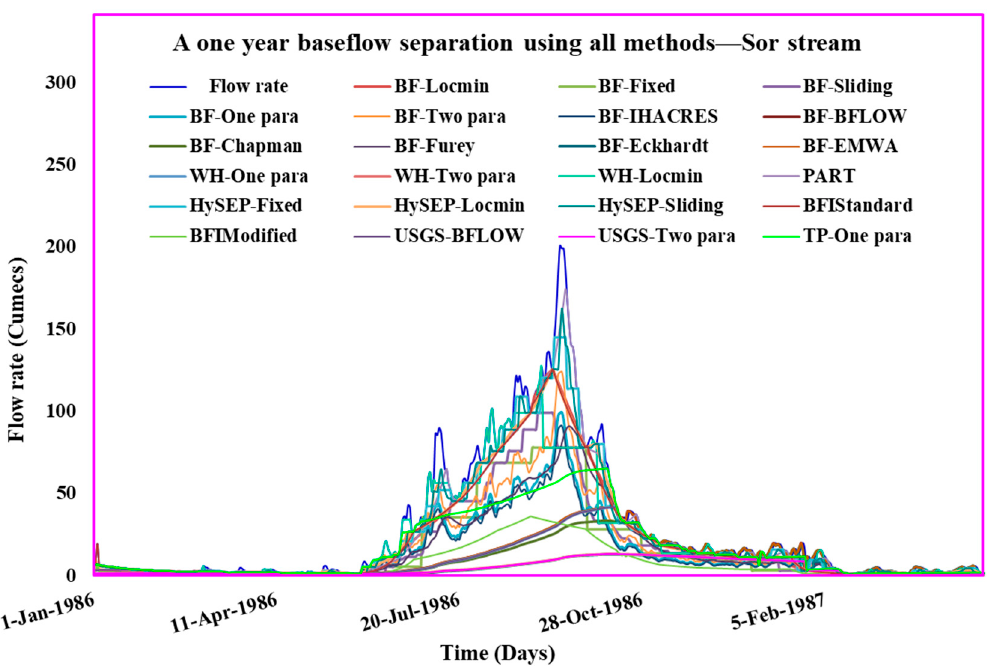
Figure 13. Baseflow separation using all automated methods for the Sor stream. (Results of all methods are displayed together. This figure shows a one-year baseflow separation).